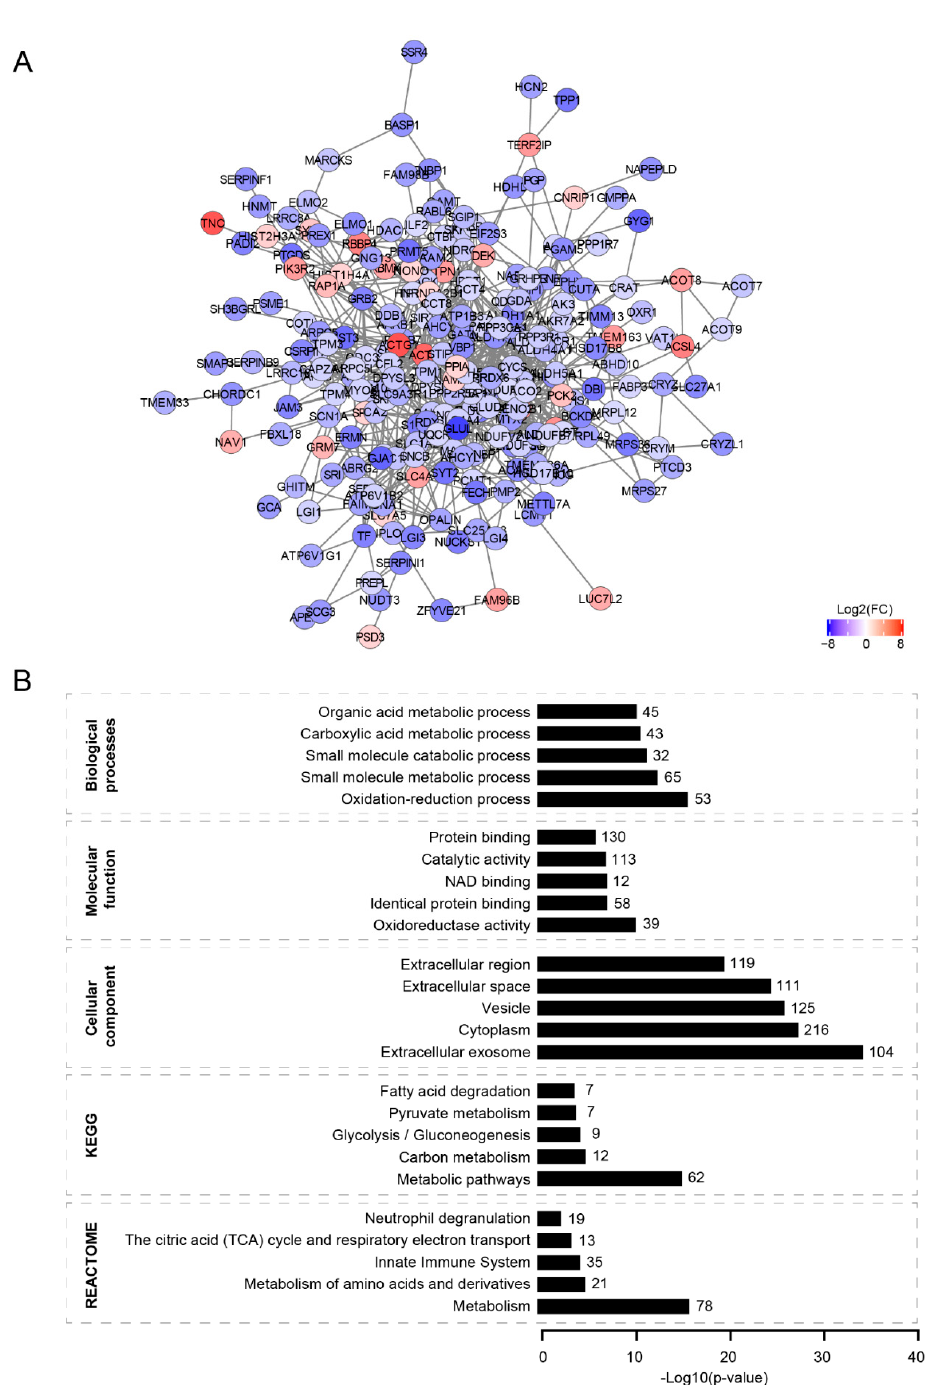
Figure 2. Protein–protein interaction network of differentially expressed proteins in VWM cortex compared to control cortex. ( A ) Protein–protein network of differentially expressed proteins in VWM cortex. The network consists of a single major component (largest subnetwork), harboring 234 of the differentially expressed proteins we identified. For visualization, only clusters with more than 4 nodes are shown. Red and blue nodes indicate upregulated and downregulated proteins, respectively. ( B ) Gene ontologies analysis of proteins clustered in the largest subnetwork. Graphs show the top 5 enriched terms (ranked by − log10 ( p -value)) for each gene ontology. The number of proteins in each term is